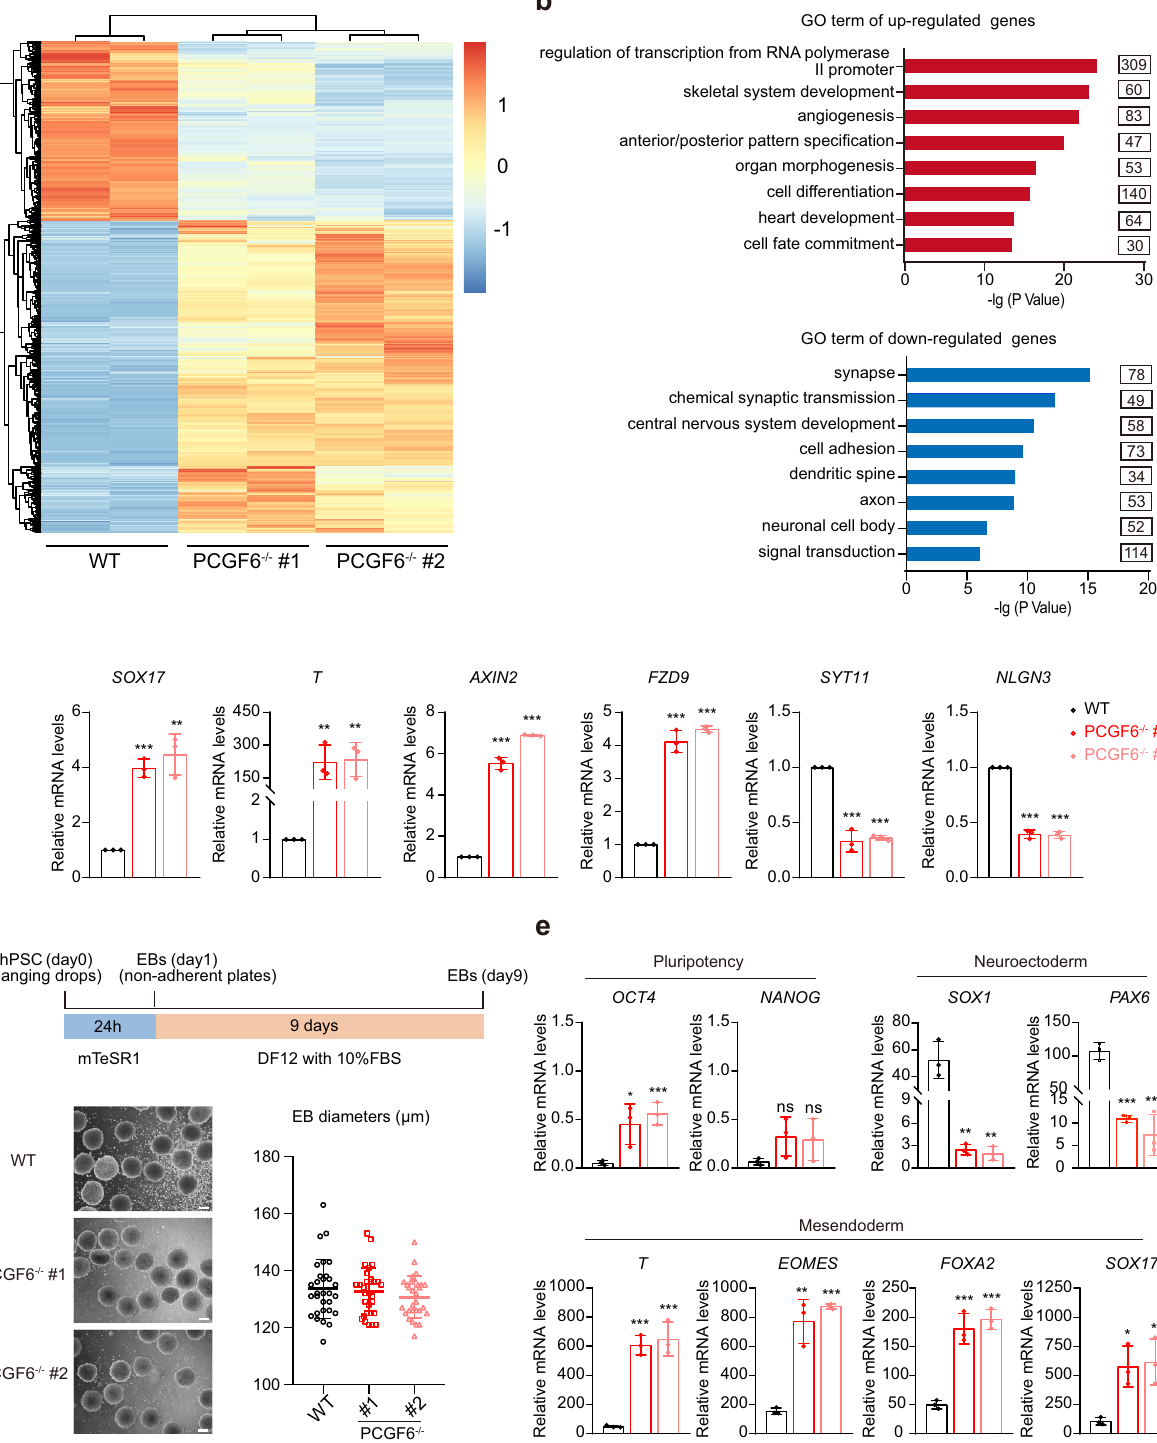
bright- fi eld images of WT and PCGF6-KO EBs at days 9 in suspension culture (left), Scale bars, 100 μ m; scatter graph displayed the mean diameter of 30 random EBs from WT and PCGF6-KO cell lines ( n =30) (right). e qRT-PCR was used to measure the relative mRNA expression levels of pluripotency markers ( OCT4 and NANOG ) and lineage-speci fi c markers (endoderm, mesoderm and ectoderm) in WT and PCGF6-KO EBs on day 9 ( n =3). Each point represents a biologicalreplicate.Dataarepresentedasthemean±SD.Statisticalsigni fi cance was determined using the unpaired, two-tailed t -test in c – e (ns not signi fi cant, * p <0.05, ** p <0.01, *** p <0.001). Exact p values and statistical parameters are provided as a Source Data fi